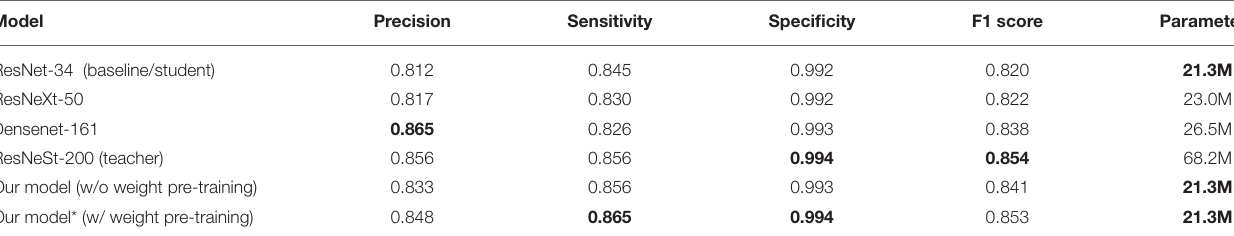
TABLE 4 | Performance